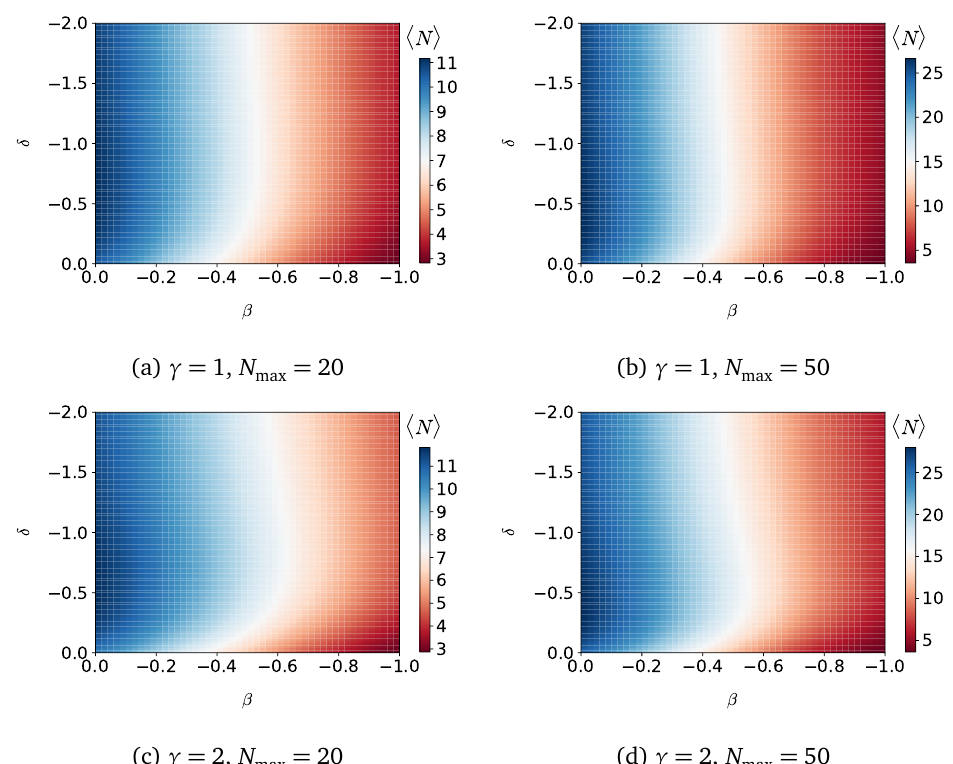
Figure 8: Heat plots showing 〈 N 〉 for a range of β and δ values. No matter what values of γ and N are chosen, the δ and β dependence remains roughly the max